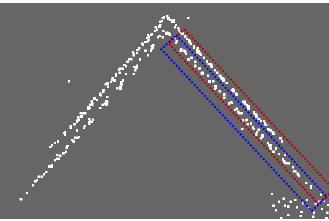
Figure 8. Plane number plot (x-axis represents building ID, y-